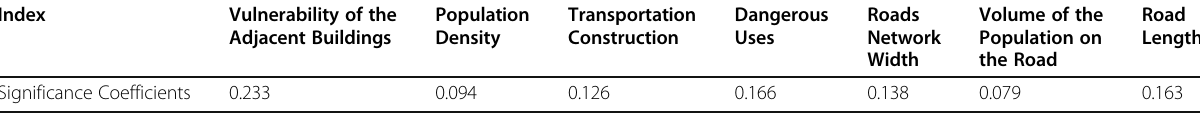
Table 7 Significance coefficients of all indices effecting the emergency evacuation and relief roads